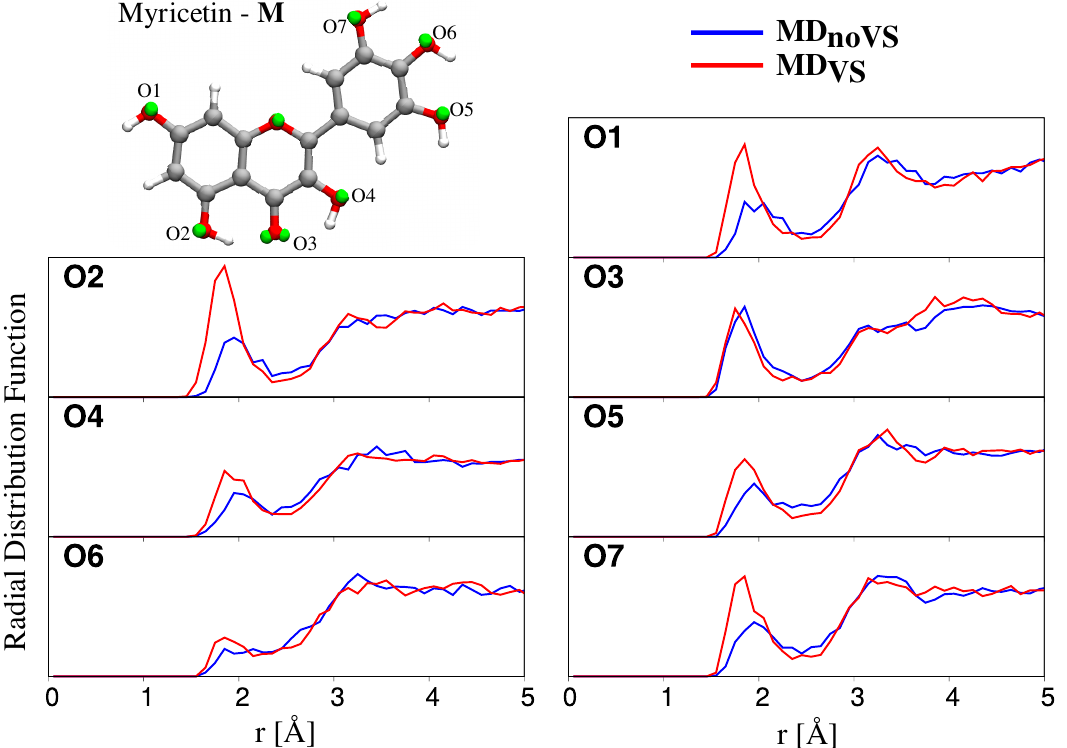
Figure 5. Radial distribution functions (RDFs) between Oxygen atoms of Myricetin and water Hydrogen atoms, as obtained from MD noVS (blue) and MD VS (red)